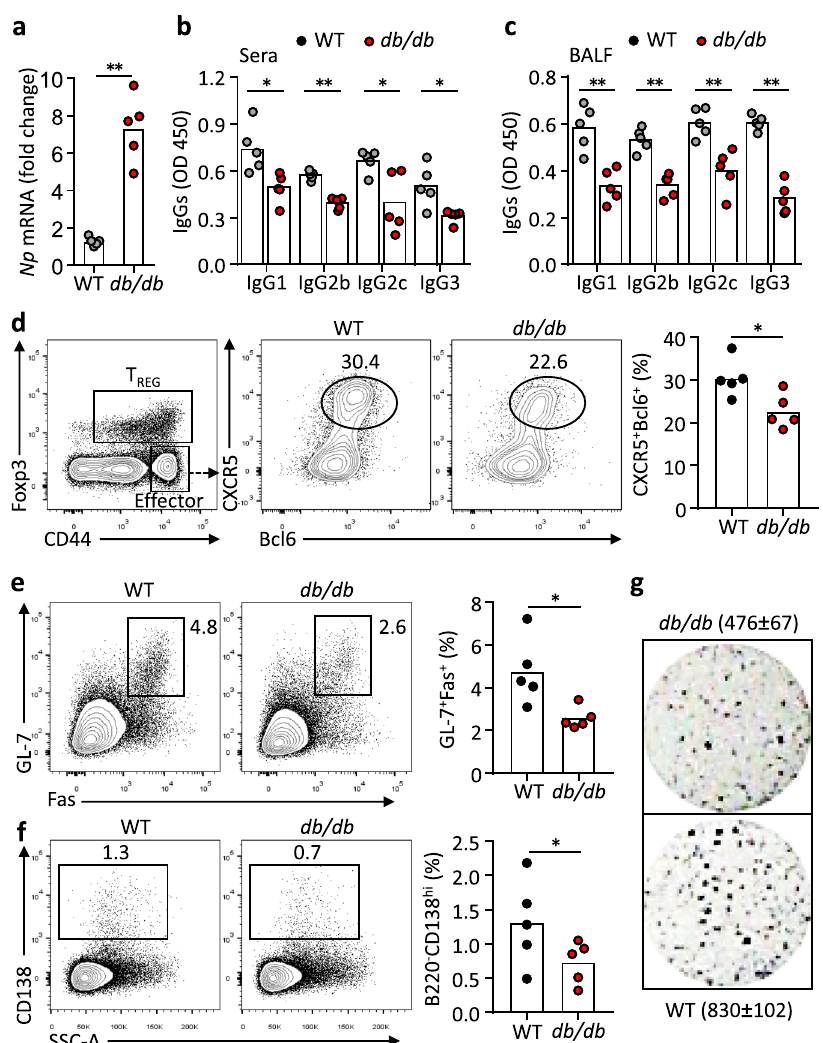
Fig. 3 LepR de fi ciency leads to impaired antibody responses after in fl uenza virus infection. a Real-time PCR analysis of nucleoprotein ( Np ) in lung tissues of WT (grey) and db/db (red) mice 9 days post H1N1 in fl uenza viral infection (** P = 0.0007). b , c ELISA measurement of H1N1-speci fi c IgG1, IgG2b, IgG2c and IgG3 in sera ( b ) (IgG1: * P = 0.0190, IgG2b: ** P < 0.0001, IgG2c: * P = 0.0299, IgG3: * P = 0.0209) and BALF ( c ) (IgG1: ** P = 0.0080, IgG2b: ** P = 0.0036, IgG2c: ** P = 0.0079, IgG3: ** P = 0.0007). d – f Representative FACS plots and statistics showing CXCR5 + Bcl6 + T FH cells ( d ) (* P = 0.0407), GL-7 + Fas + germinal centre (GC) B ( e ) (* P = 0.0240) and CD138 high antibody-secreting cells (ASCs) ( f ) (* P = 0.0411) in mediastinal lymph nodes. g ELISPOT assay showing virus-speci fi c ASCs in spleens. Data are shown for individuals (dots, n = 5 per genotype) and mean (bars) values, and analysed by Mann – Whitney U-test ( a – f ). * P < 0.05, ** P < 0.01. Results are representative of three independent